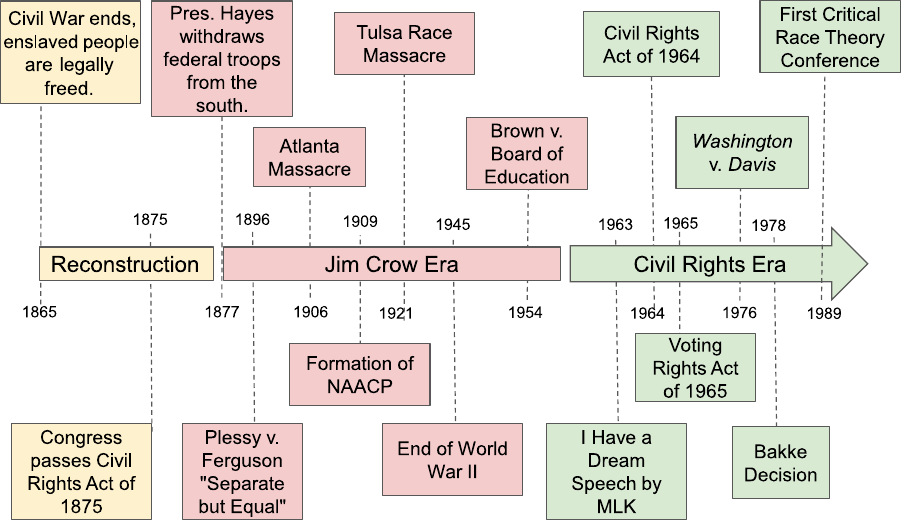
FIG. 1. Historical timeline of events leading to